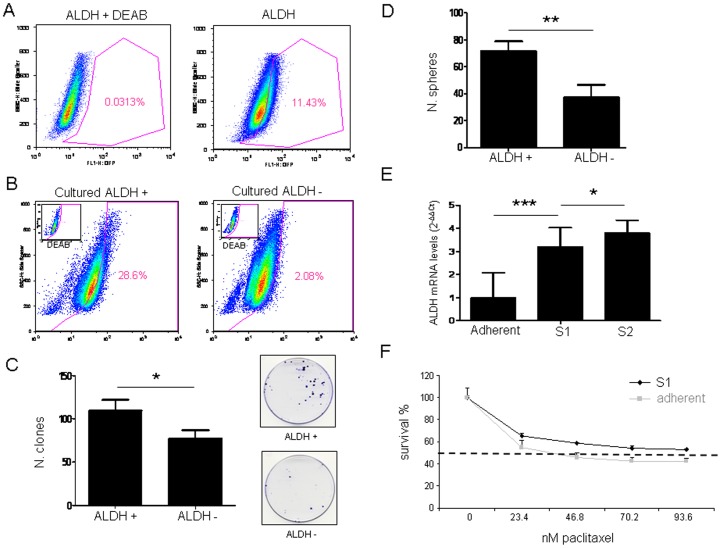
The ALDH+ LLC cell population displays CSC-like characteristics.
A. The ALDH+ cell fraction (measured by Aldefluor assays) represents ∼11% of total cells in the LLC cell line. B. Isolated LLC ALDH+ cells possess self-renewal ability as shown by their capacity to generate both ALDH+/− populations after 8 days in culture, while ALDH− cells only give rise to negative cells. C. Number of clones generated by LLC ALDH+ and ALDH− cells after sorting. The ALDH+ population shows higher clonogenic capacity than their negative counterpart. D. Number of spheres generated by LLC ALDH+/− cells. E. qRT-PCR analysis of ALDH1A1 mRNA levels in LLC cells cultured in adherent conditions, primary spheres (S1) and spheres of second generation (S2). F. Chemoresistance to paclitaxel of LLC grown in either adherent conditions or in spheres (S1) was measured with an MTT assay. IC50 for adherent LLC cells: 35.8 nM; IC50 for LLC S1 spheres: >93.6 nM. Data and error bars: mean ± SD. *p<0.05. **p<0.01. ***p<0.001. All the experiments were repeated at least 3 independent times (each of them in triplicates).